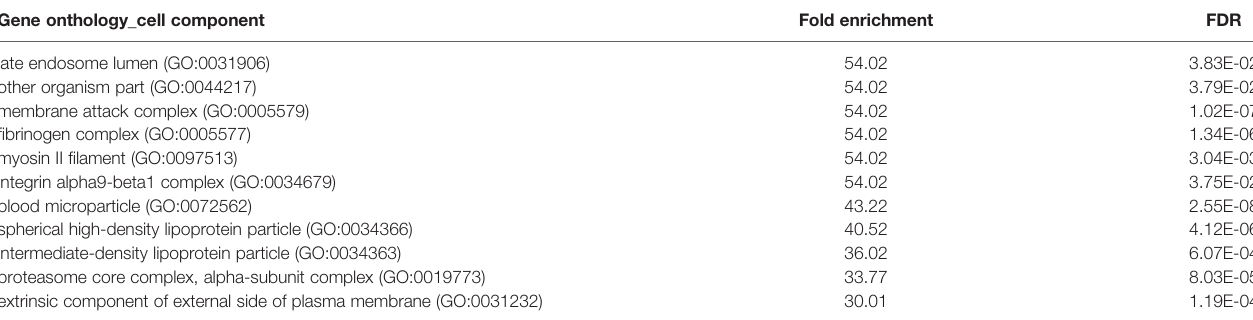
TABLE 1 | Gene ontology (cellular component category) analysis of the differentially expressed EV proteins at 24 h post-surgery. Gene onthology_cell component